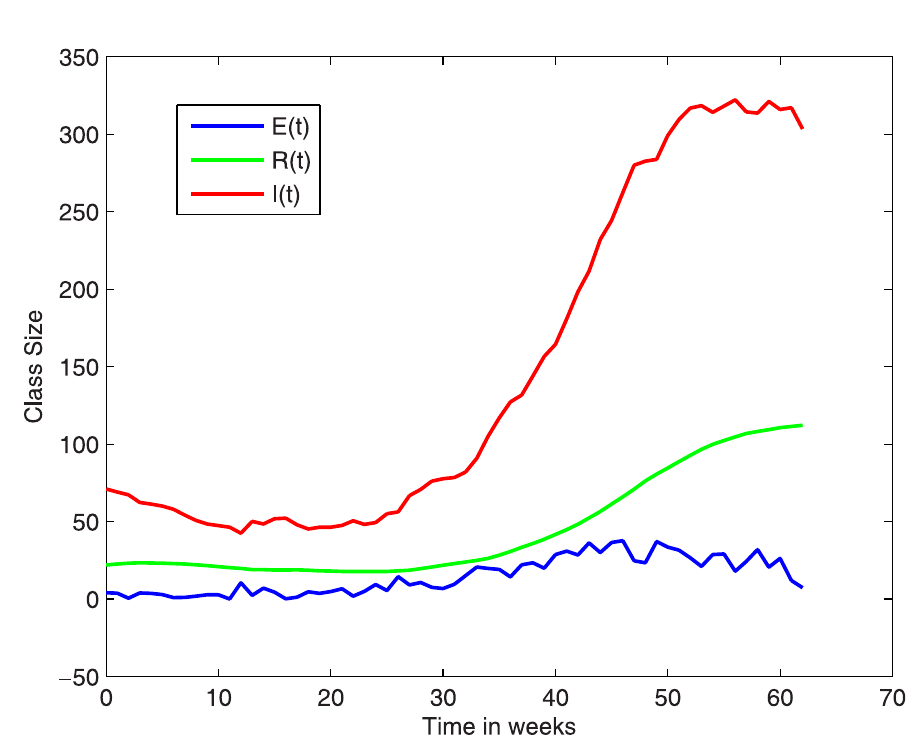
Fig 4. The trajectories of the E, I and R -classes over the outbreak period, based on the rough data.